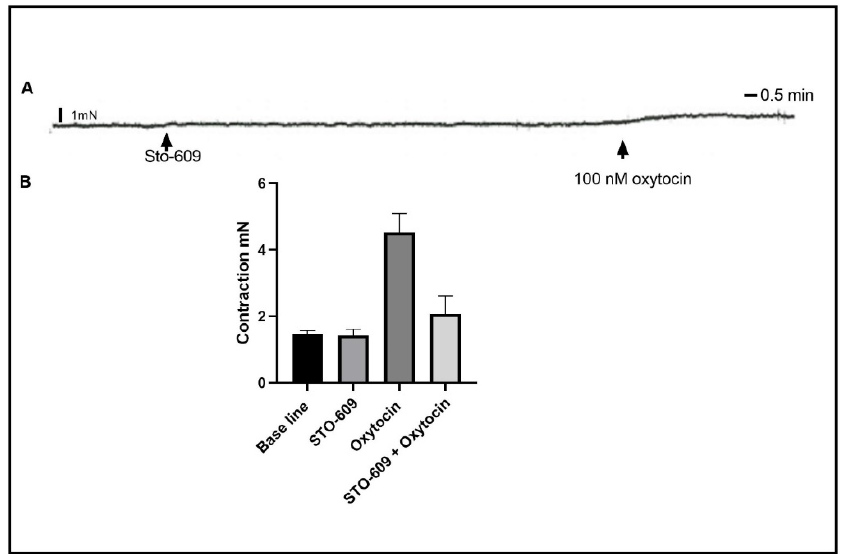
Figure 6. Effect of inhibition of Ca 2+ /calmodulin-dependent protein kinase (CaM-KK) on oxytocin- induced contraction. ( A ) is a representative trace illustrating oxytocin-induced contraction after 30 min of pre-incubation with the CaM-KK inhibitor STO-609. ( B ) is a summary graph illustrating oxytocin-induced contraction significantly inhibited by STO-609. Data expression is in mN of force. Values are mean ± SEM. n = 4.